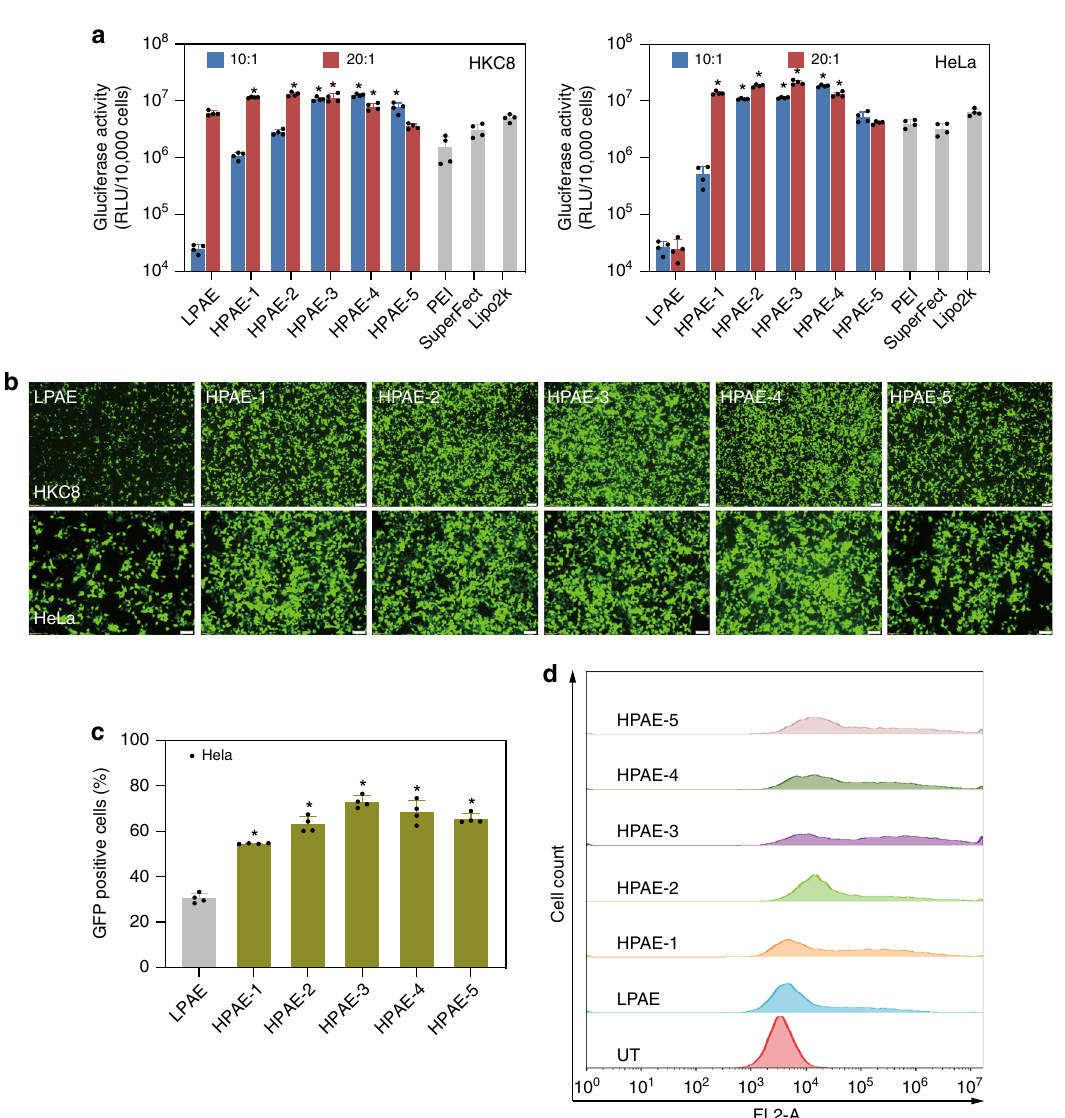
Fig. 3 HPAEs show much higher transfection ef fi cacy than LPAE and commercial reagents. a Gluciferase activity of HKC8 and HeLa cells after 48 h transfection with different vectors at w / w ratios of 10:1 and 20:1. Data points marked with asterisks (*) are statistically signi fi cantly higher relative to the Lipo2k group. b Fluorescence images of HKC8 and HeLa cells 48 h post transfection with various vectors at the w / w ratio of 20:1. The scale bars for HKC8 cells represent 200 μ m, for HeLa cells represent 100 μ m. c The percentage of GFP-positive Hela cells after transfection, asterisk indicates signi fi cantly higher transfection ef fi ciency in comparison with the LPAE group. d Representative histogram distributions of untreated (UT) HeLa cells and the ones after transfection with HPAEs at the w / w = 20:1. Data are shown as average ± SD; n =